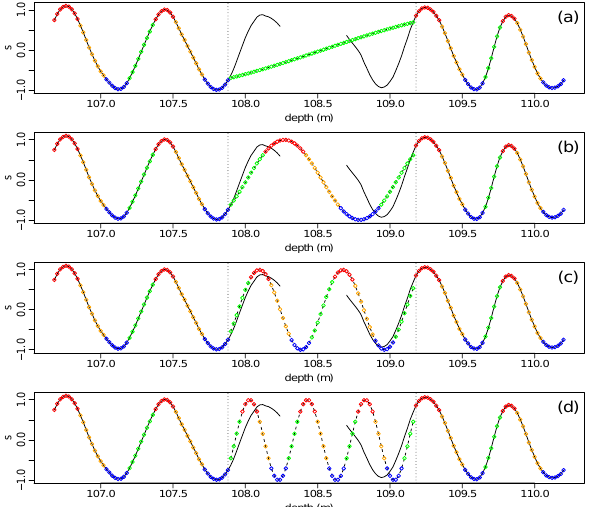
Fig. 4. Four possible reconstructions of an “issue” (region of dat- ing uncertainty, bounded by the dotted lines) caused by missing values in the standardised H 2 O 2 signal (black curve) at a depth of around 108.5m. Coloured points within the issue represent imputed values for missing observations, or conjectured “corrected” values for nearby observations; coloured points outside the issue indicate the classification of actual observations. In each case, points clas- sified as being within peaks (labelled P in main text) are coloured red, descending points (D) orange, troughs (T) blue, and ascend- ing points (A) green. The four different reconstructions are indexed by d , the number of runs (sets of consecutive points classified in the same way) used to reconstruct the issue, including the adjacent runs; adding an extra year to the reconstructed chronology increases d by 4. (a) The minimal reconstruction, with no additional annual cycles, involving d = 1 runs. (b) The reconstruction with one addi- tional annual cycle and d = 5. (c) The reconstruction with two ad- ditional annual cycles and d = 9. (d) The reconstruction with three additional annual cycles and d =